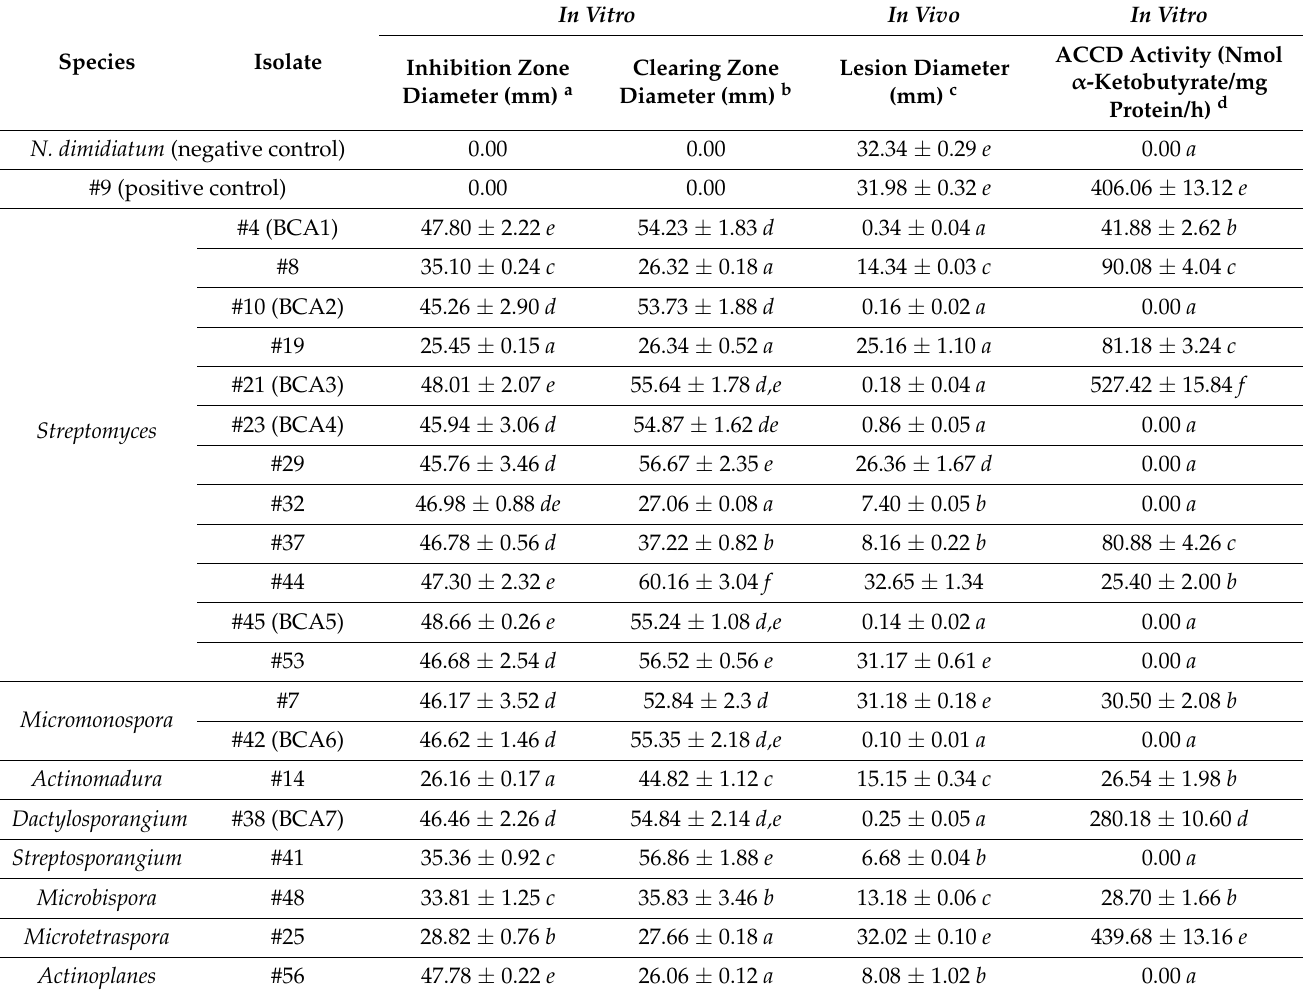
Table 1. Antagonism against Neoscytalidium dimidiatum and production of ACCD by 20 SA and NSA isolates.